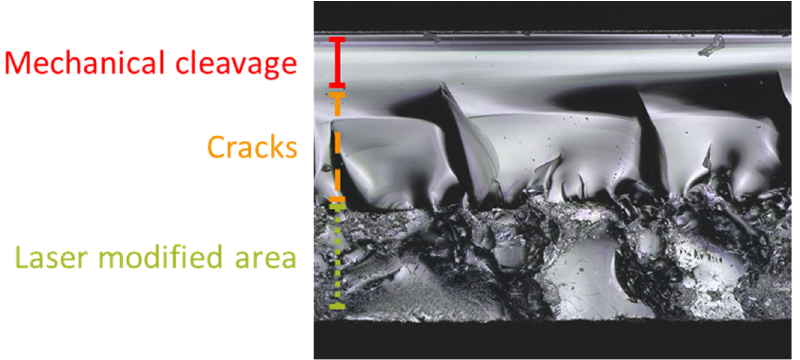
Figure 6. Sidewall profile showing mechanical cleavage, cracks, and laser-damaged areas (adapted from [16]). Table 3. Roughness measurements for sidewall of cleaved sample shown in Figure 6 [16].